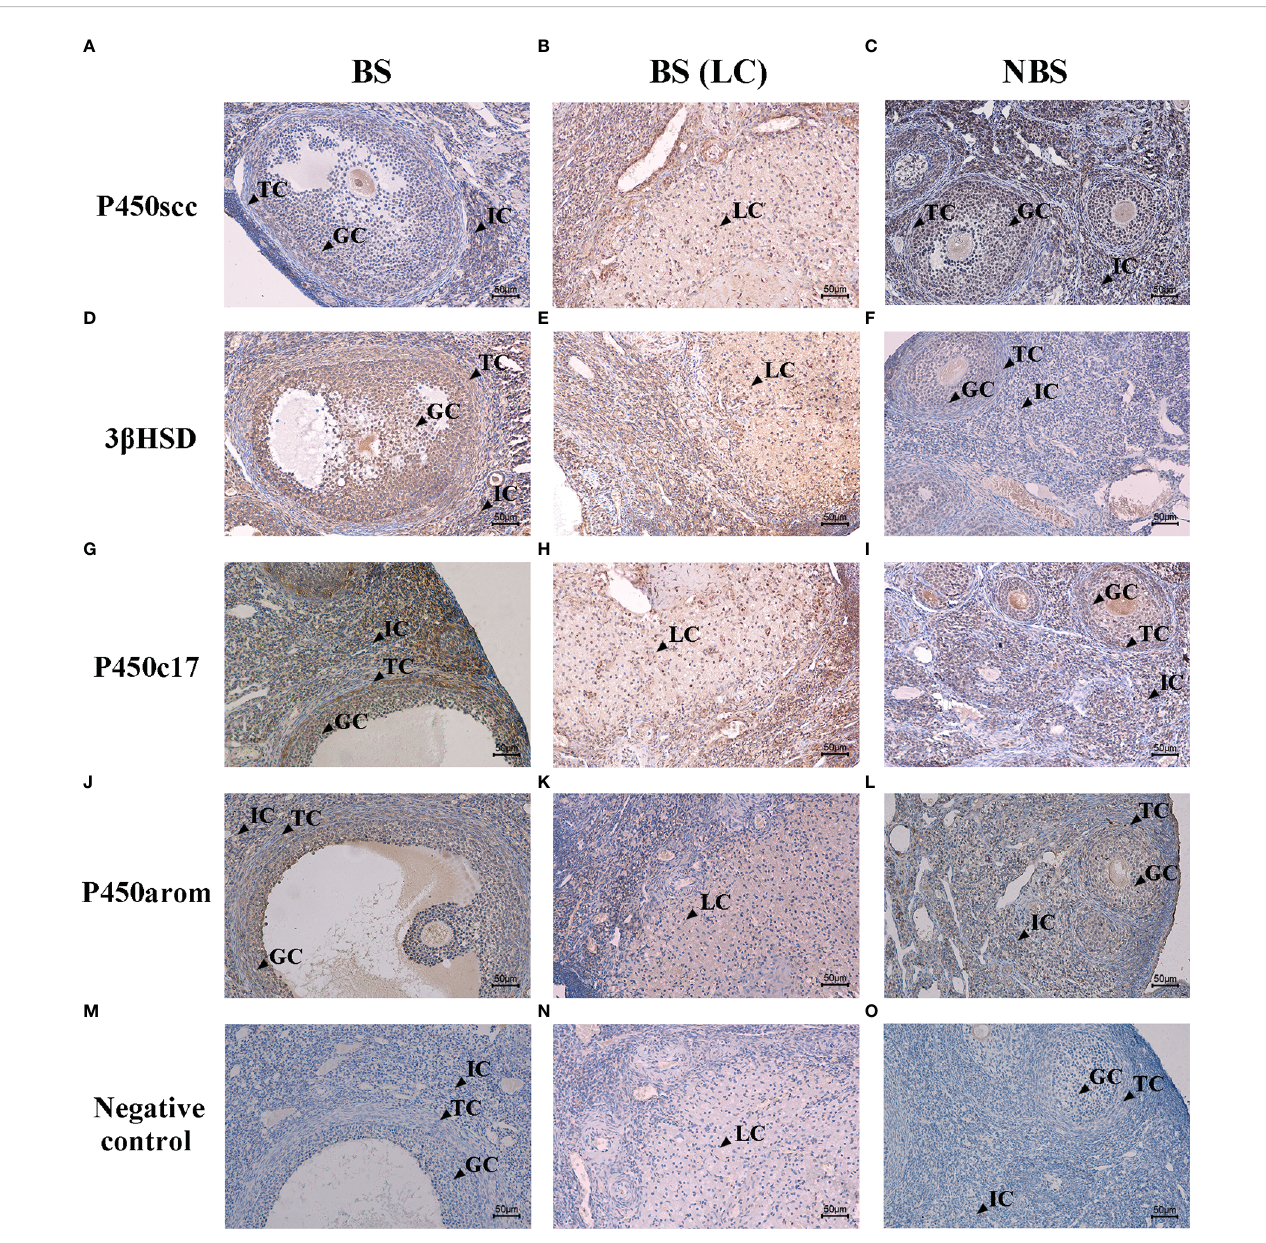
FIGURE 5 Immunohistochemical localization of P450scc (A – C) , 3 b -HSD (D – F) , P450c17 (G – I) , and P450arom (J – L) in ovaries of the muskrats during breeding and non-breeding seasons. The negative control of the ovaries sections in breeding season (M, N) and non-breeding season (O) . BS, breeding season; NBS, non-breeding season. GC, granulosa cells; TC, theca cells; IC, interstitial cells; LC, luteal cells. Scale bars represent 50 m